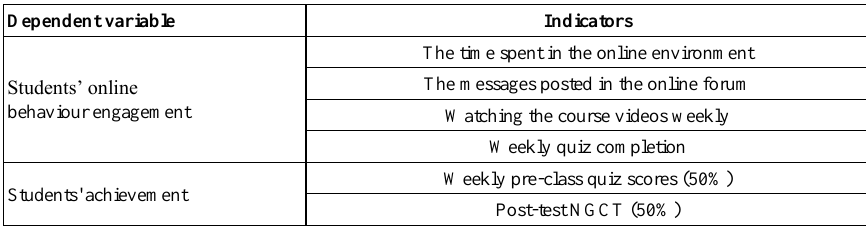
Table 5. Measures for online behaviour engagement, and achievement